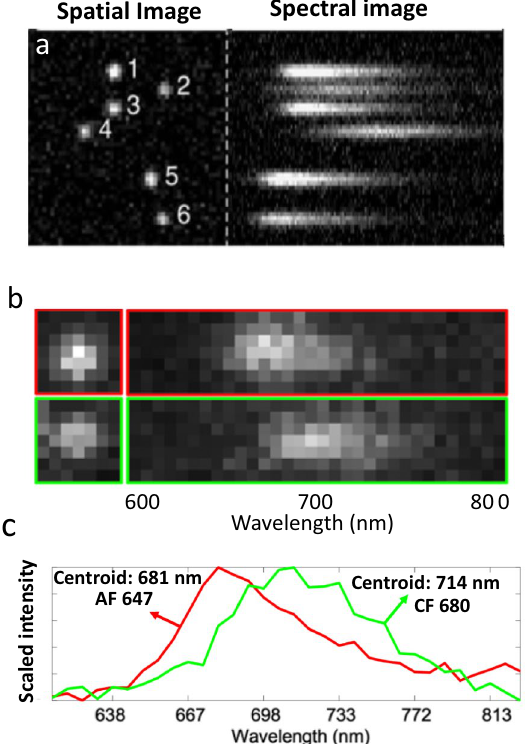
Fig. 1 a Example of spatial (left) and spectral (right) images in sSMLM; b Spatial and spectral images of AF 647 (top, red) and CF 680 (top, green); c Calibrated spectra of imaged AF647 and CF 680 (Reprinted with permission from [25] and [31])